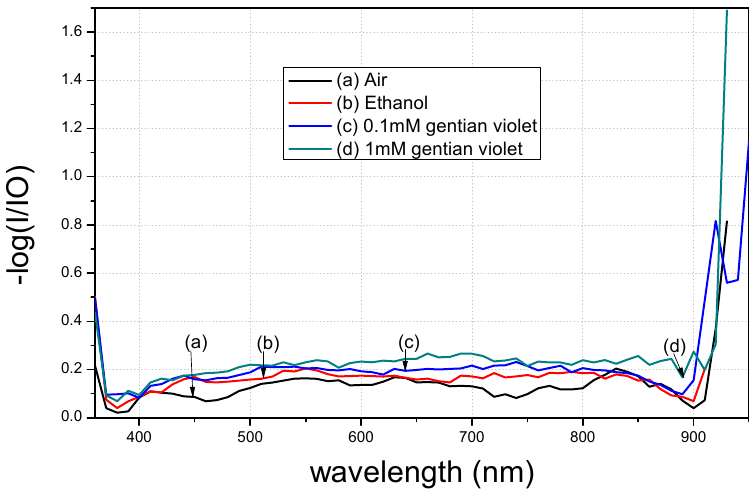
Figure 12. Transmittance of the modified fiber by MPTMS treated with t-dodecyl